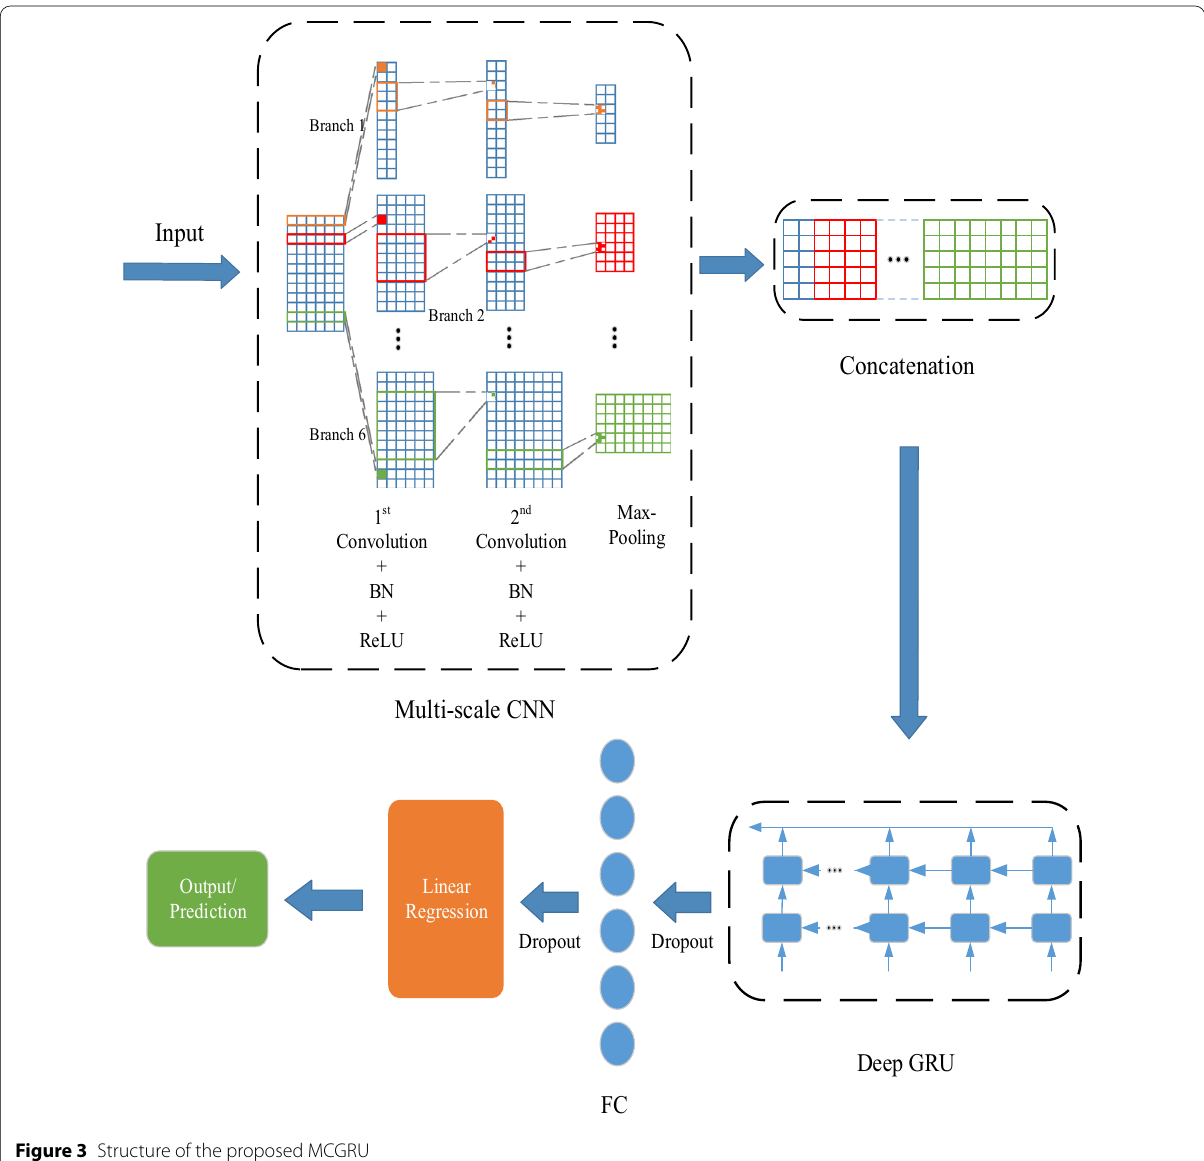
Figure 3 Structure of the proposed